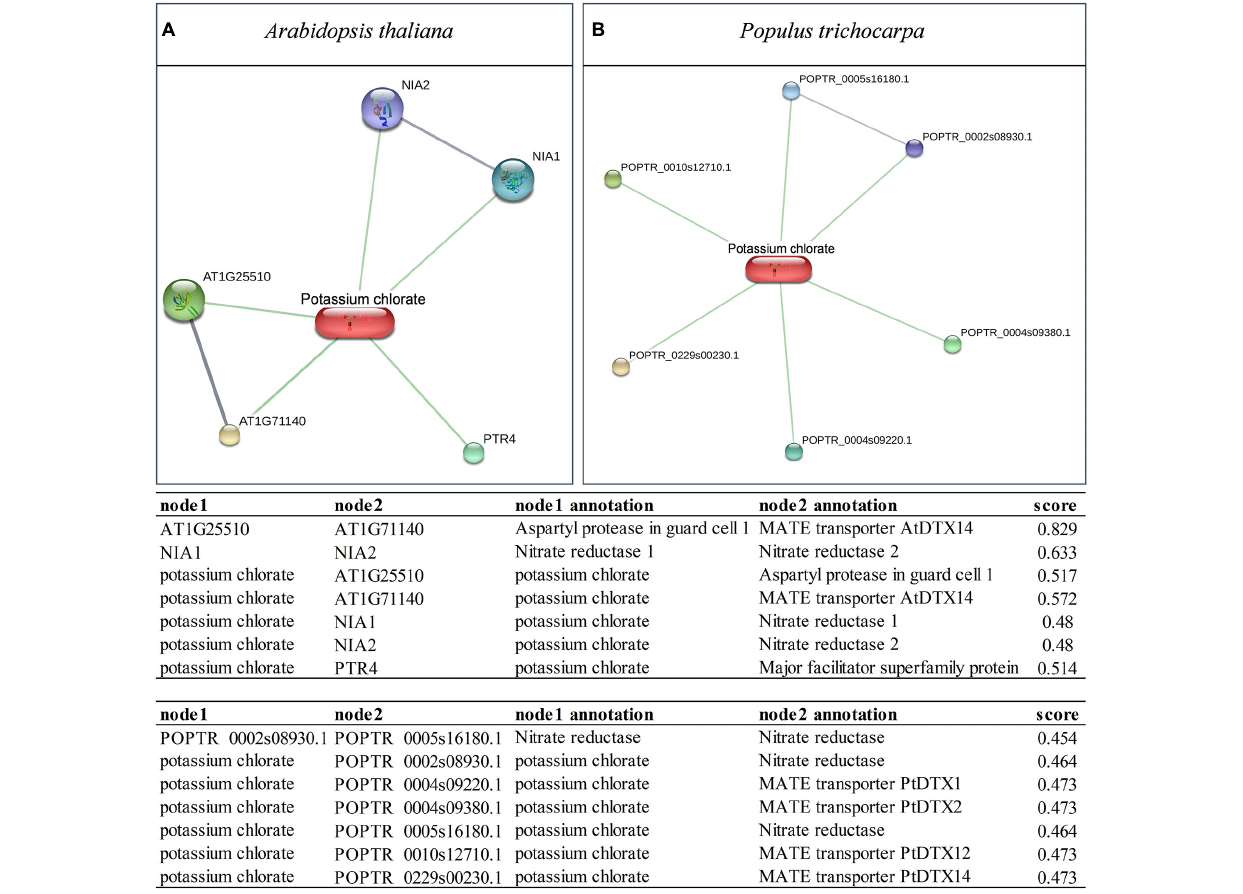
FIGURE 1 | Interactions of potassium chlorate and proteins in Arabidopsis thaliana (A) and Populus trichocarpa (B) searched by STITCH 5.0. (A) Generated by input “Item Name: potassium chlorate, Organism: Arabidopsis thaliana ”; (B) Generated by input “Item Name: potassium chlorate, Organism: Populus trichocarpa. ” Stronger associations are represented by thicker lines and higher scores in the follow table. Protein-protein interactions are shown in gray and chemical-protein interactions in